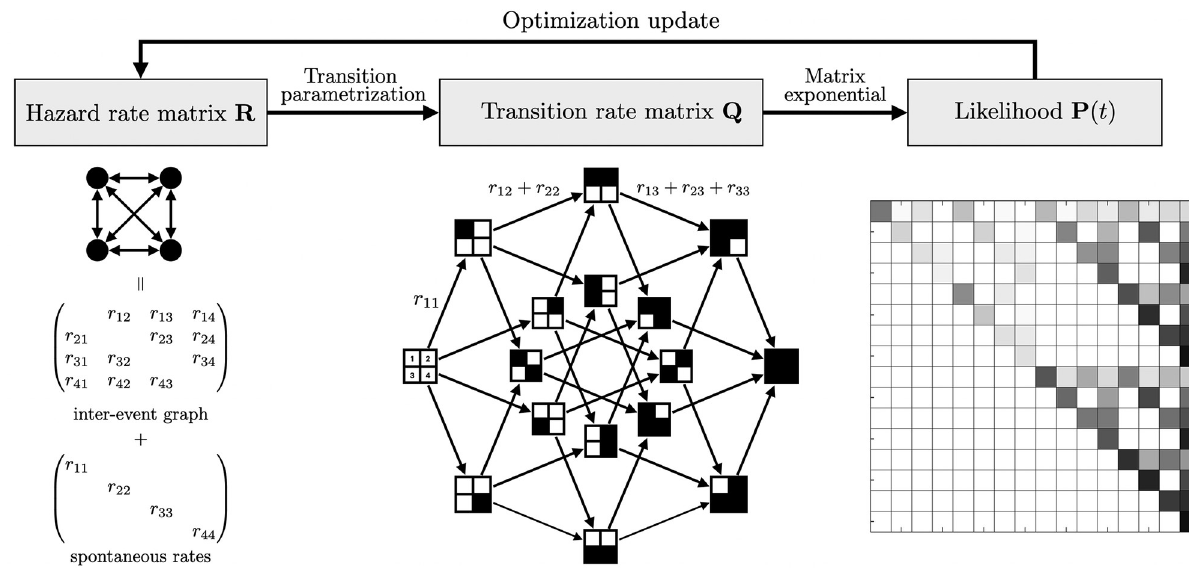
Fig 1. Overview of the proposed